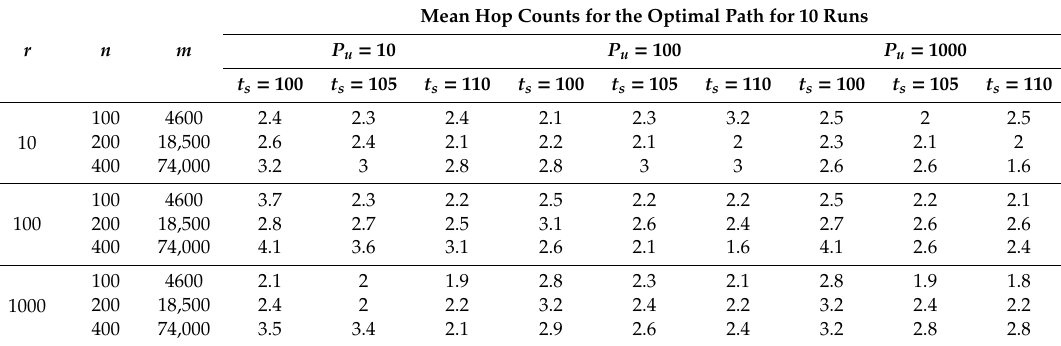
Table 6. Mean hop counts for the e ff ective path for the SESE algorithm for 10 Mb